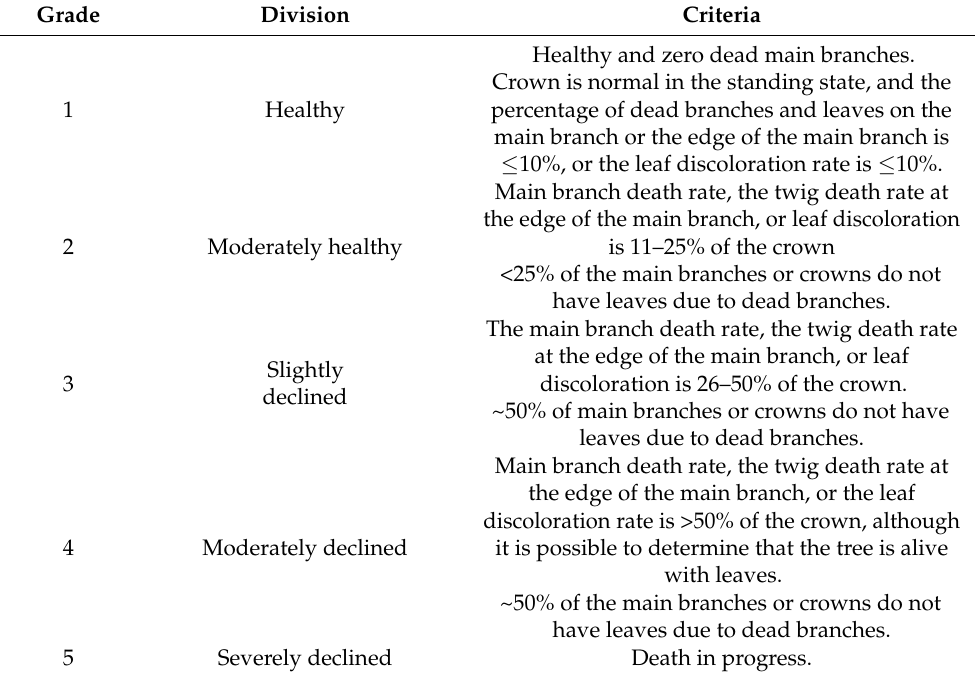
Table 1. Criteria on tree vitality in forest health monitoring implemented in the ROK [18].